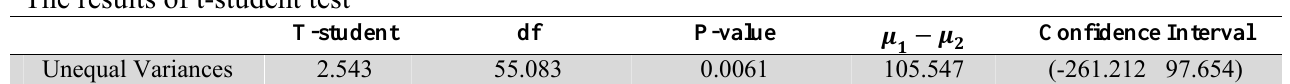
T-student Confidence Interval Unequal Variances